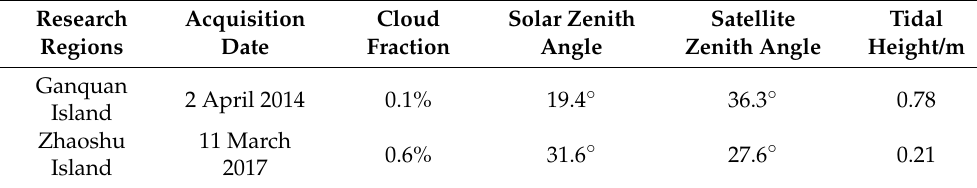
Table 1. Parameter information of WorldView-2 images in two